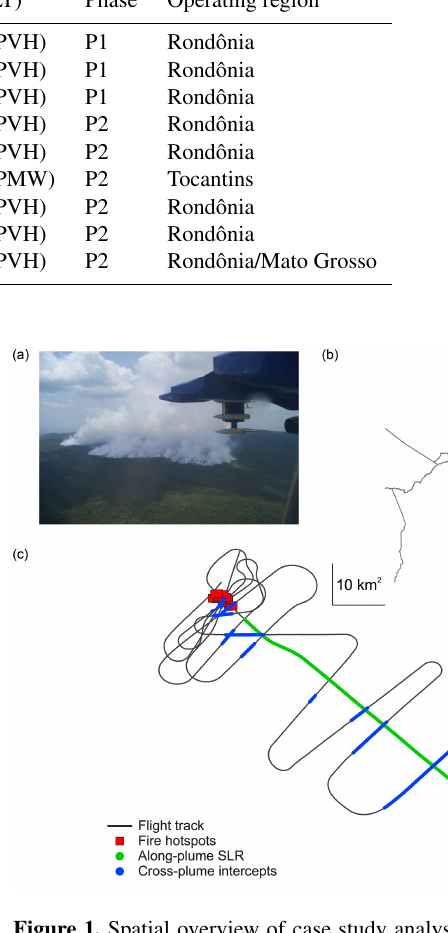
Figure 1. Spatial overview of case study analysis for flight B737. (a) Photograph taken from the aircraft of the fire, courtesy of William T. Morgan. (b) Flight track of B737 in relation to the wider study region. (c) Low-level flight track of the case study, indicating both cross-plume intercepts and the along-plume straight-and-level run (SLR). Also shown are Moderate Resolution Imaging Spectro- radiometer (MODIS) hotspot data from the Terra overpass coinci- dent with our flight sampling. The 10km 2 box represents the scale for the flight